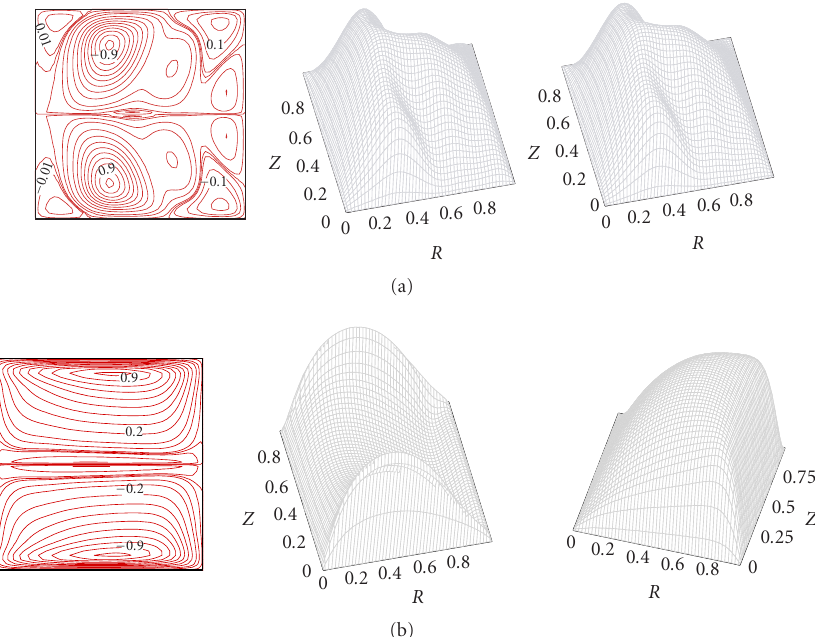
Figure 3: Flow and temperature fields ( σ = 0 . 02, Pr = 0 . 7, Dk = 300, and L 1 = 28; left: secondary flow, middle: streamwise velocity, right: temperature): (a) L 2 = − 17 on AS 1( | ψ | max = 7 . 14, w max = 0 . 606, t max = 127 . 3) and (b) L 2 = 65 on AS 1( | ψ | max = 14 . 23, w max = 0 . 0137, t max = 8 . 9).